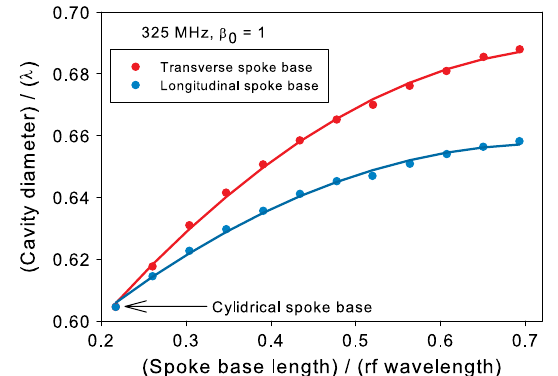
FIG. 14. Dependence of the cavity diameter on the spoke base length. A cylindrical base has the highest surface fields, but the smallest cavity